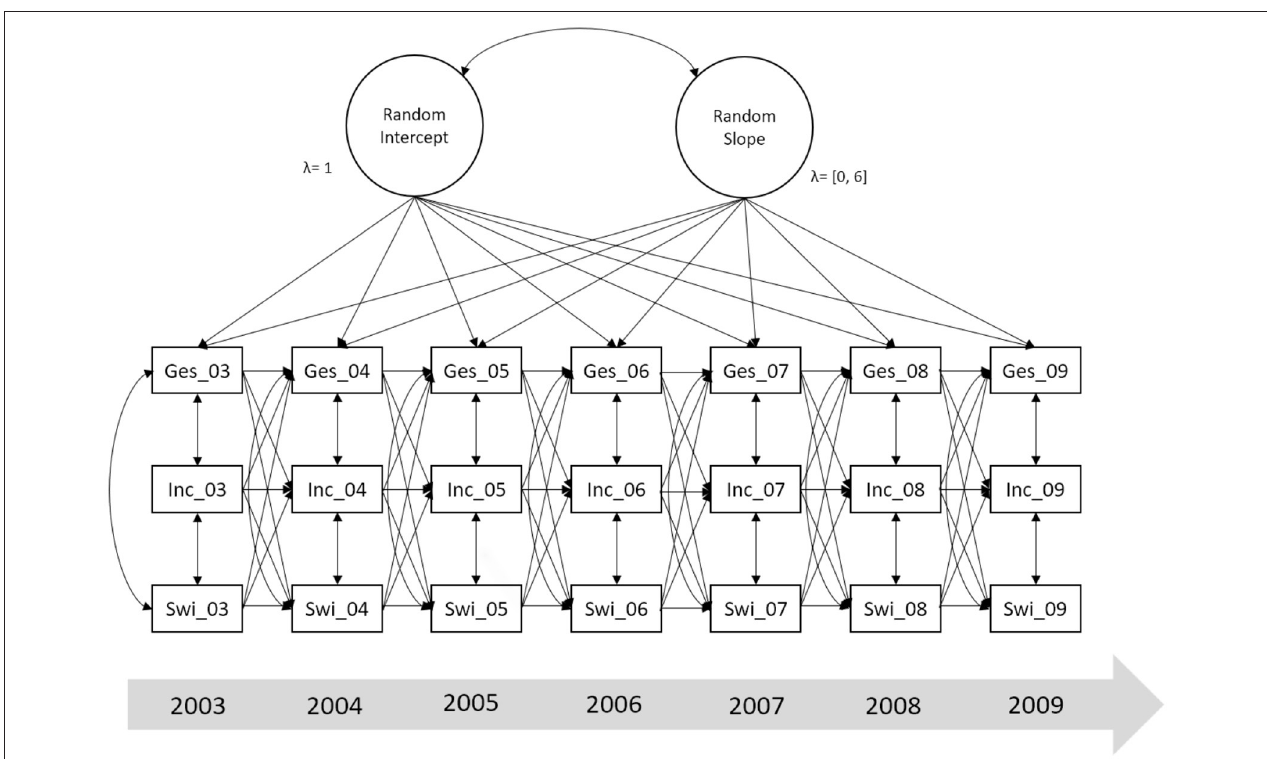
FIGURE 1 | Simplified schematic of the autoregressive latent trajectory model of health status, income satisfaction, and locus of control. ges, subjective health status; inc, satisfaction with income; swirk, locus of control; 03–09, years. The diagram is simplified to facilitate understanding and interpretation. The actual model includes random intercepts and random slopes for all three constructs. Additionally, it includes phantom latent variables that act as go-betweens between the observed variables and the random intercepts and slopes. Furthermore, residual variances are not